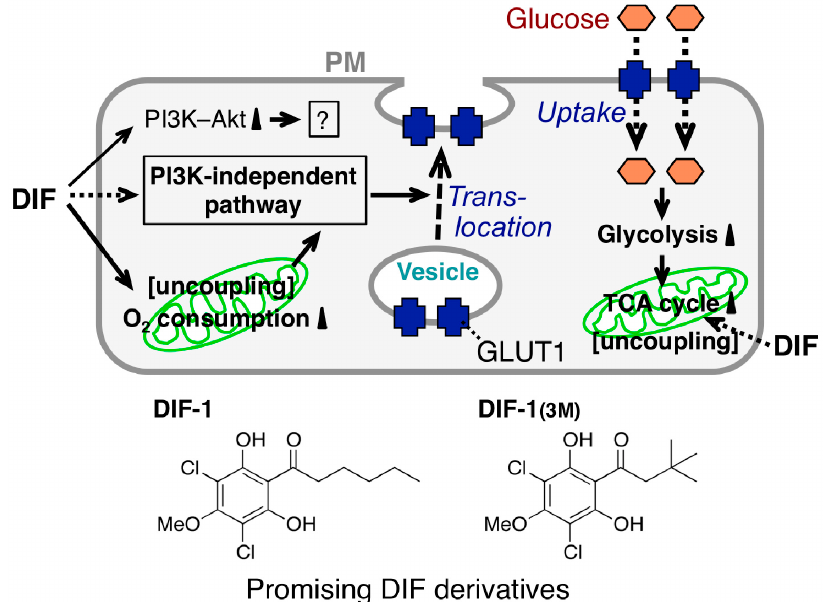
Figure 6. Proposed scheme for the glucose uptake ‐ promoting effect of DIFs. Stimulation with a DIF induces glucose transporter 1 (GLUT1) translocation from intracellular vesicles to the plasma membrane (PM) via a PI3K–Akt ‐ independent pathway, resulting in the promotion of glucose uptake by confluent mammalian cells [84]; the DIFs activate PI3K and Akt but this is not related to the DIF glucose uptake-promoting activity [84]. The DIFs also function as mitochondrial uncouplers, promoting oxygen consumption [77] and glucose metabolism (glycolysis and subsequent degradation in the tricarboxylic acid (TCA) cycle) [85] by mitochondria; this further increases GLUT1 translocation and promotes glucose uptake into the cells. Chemical structure-activity relationship analysis revealed that DIF-1 and DIF-1 (3M) are promising lead compounds for the development of anti-diabetes and anti-obesity drugs [71,84,85].